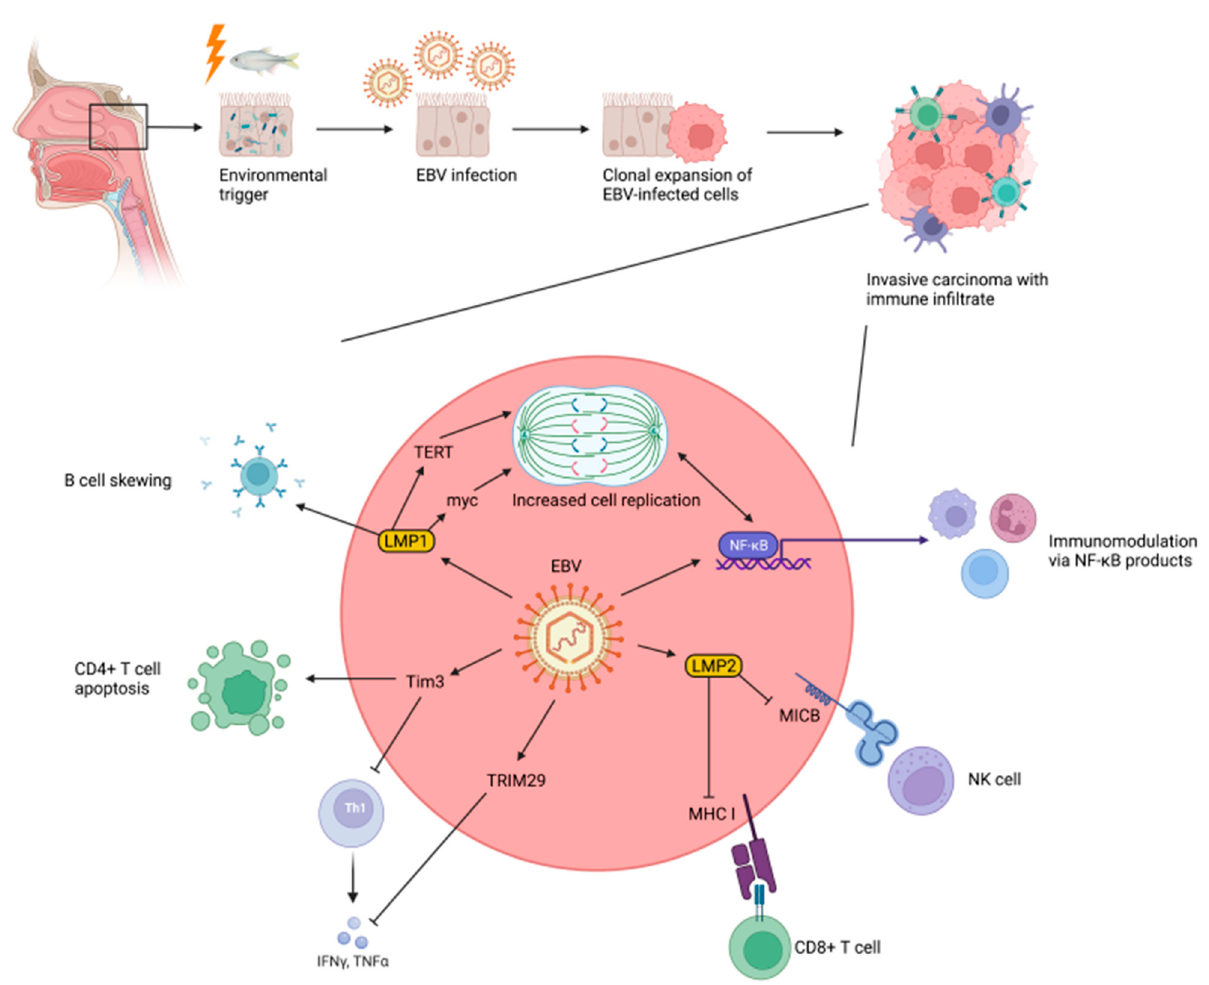
Figure 3. Growth and immune evasion of EBV-mediated NPC. Typical pathway for EBV infection and cellular transformation ( top ). Mechanisms of EBV-mediated cellular transformation and immune evasion ( bottom ). EBV alters immune checkpoints, including TIM-3 and TRIM29 [139]. The virus also alters the immune system via modulation of NFkB. [140]. EBV-specific products LMP1 [141] and LMP2 [142] also alter the cell cycle and aid in immune evasion [128]. Figure generated using BioRender.